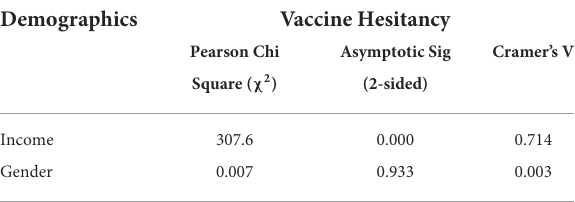
TABLE 2 Vaccine hesitancy according to the demographics.